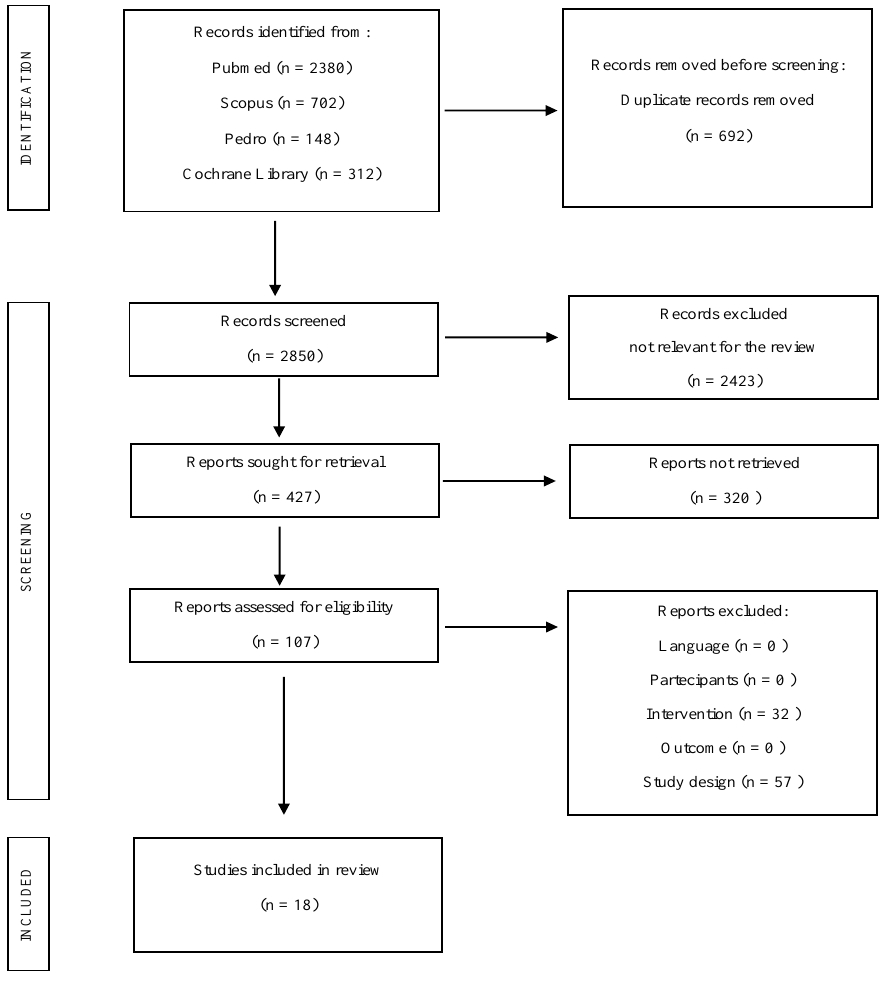
Figure 1. Flow chart.